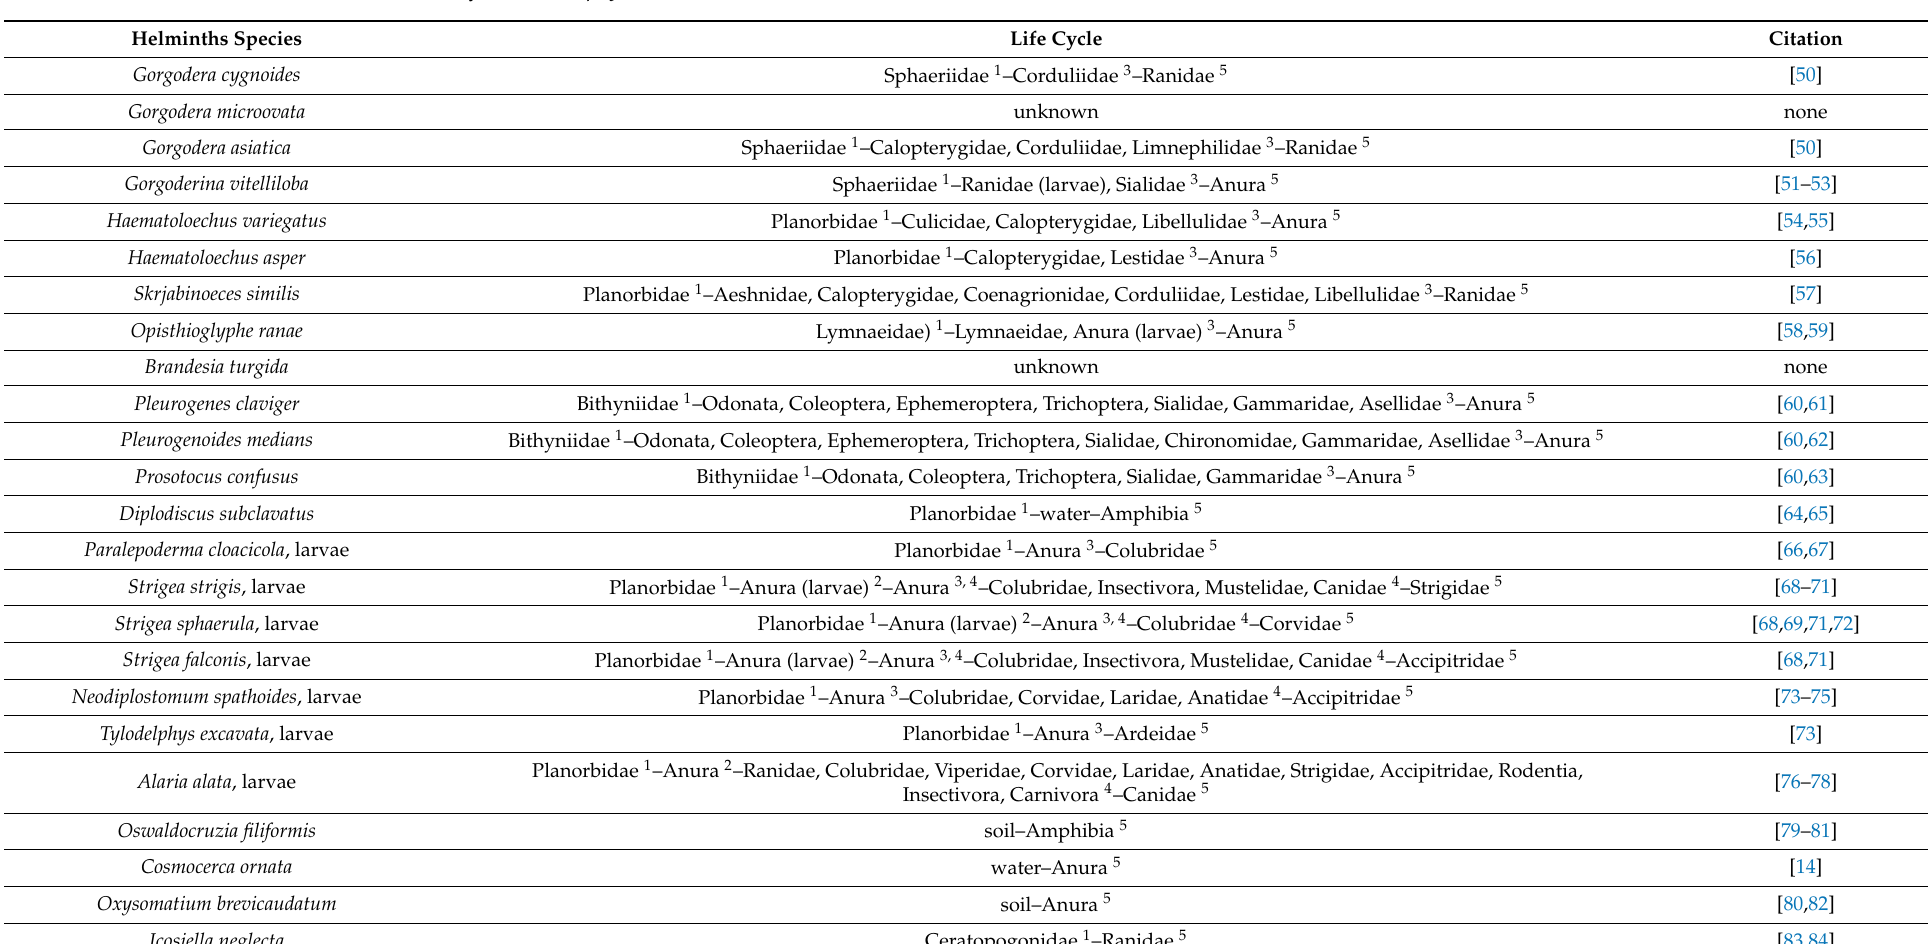
Table 2. Life cycles of Pelophylax lessonae